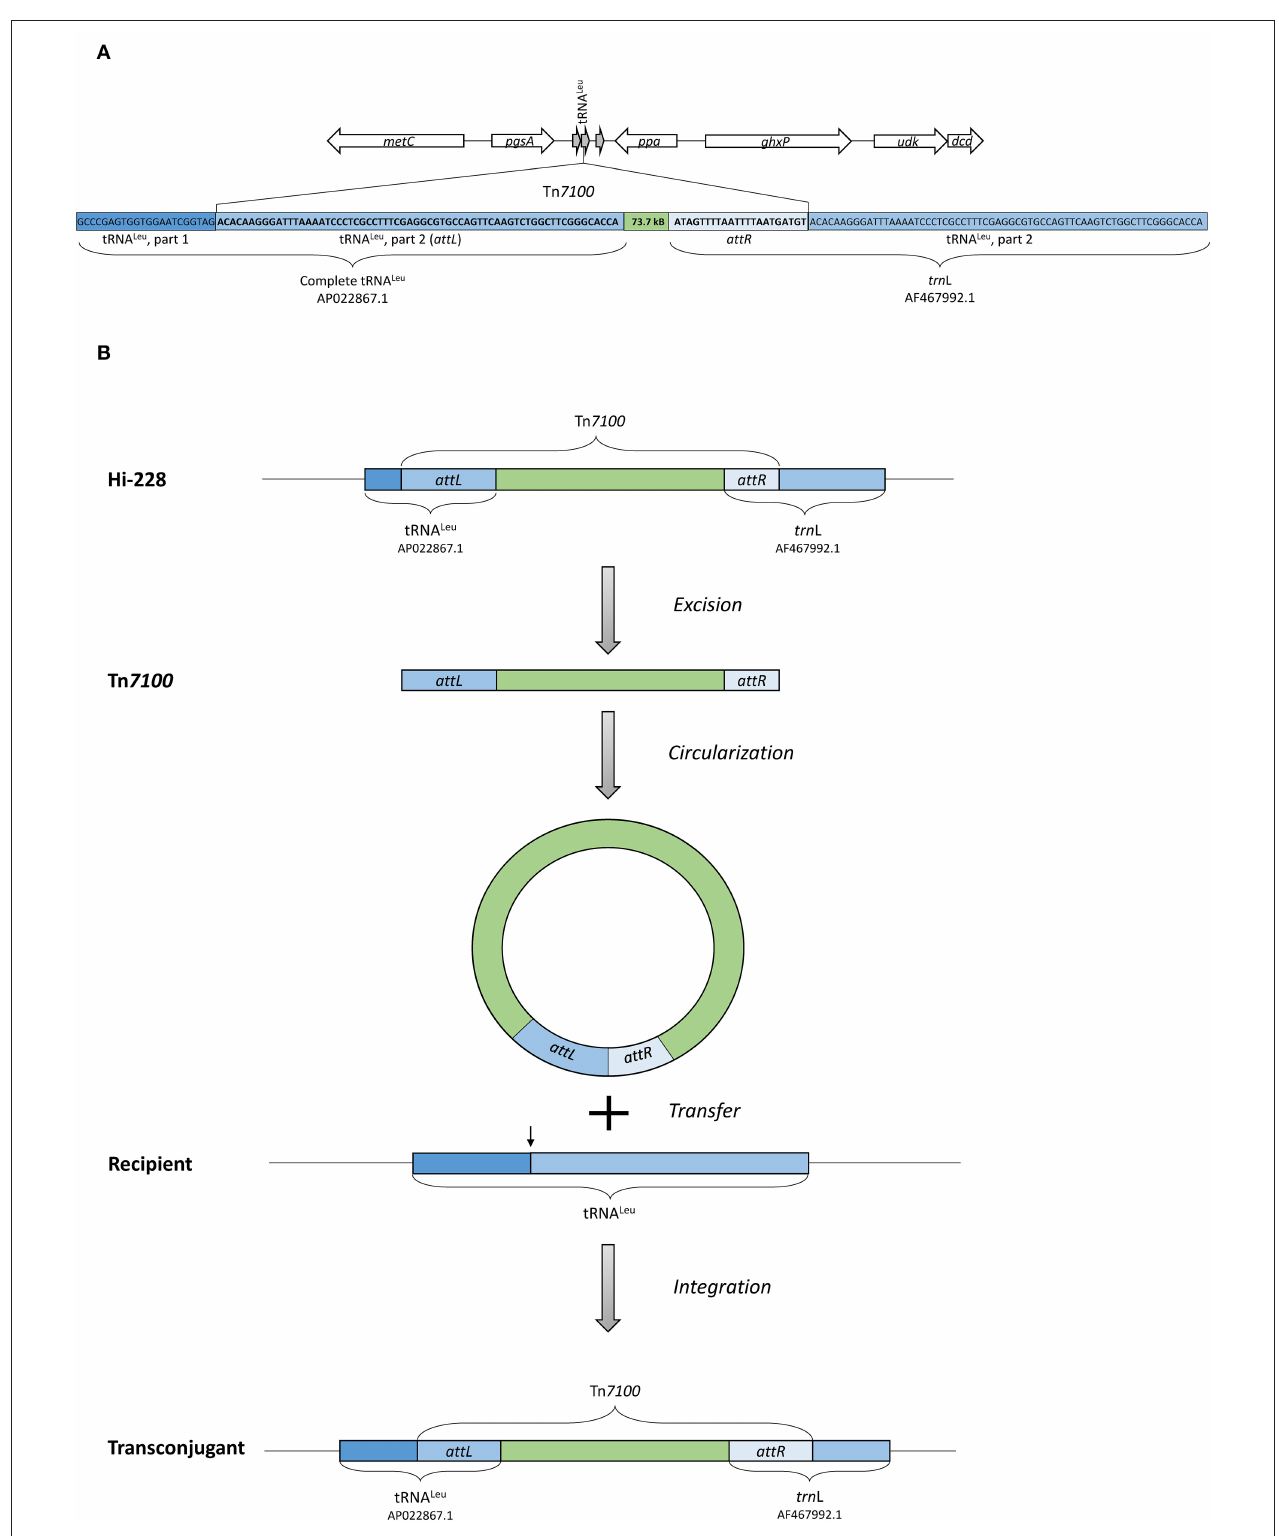
FIGURE 4 | (A) Illustration of the insertion point of Tn 7100 in Hi-228, which is located in a tRNA Leu gene. The insertion of Tn 7100 results in a complete tRNA Leu gene (AP022867.1) at the left attachment site (attL) and a complete trn L gene (AF467992.1) at the right attachment site (attR). (B) Illustration of excision, circularization, transfer, and integration of Tn 7100 from Hi-228 to the recipient strain, as confirmed by experimental procedures in this study.